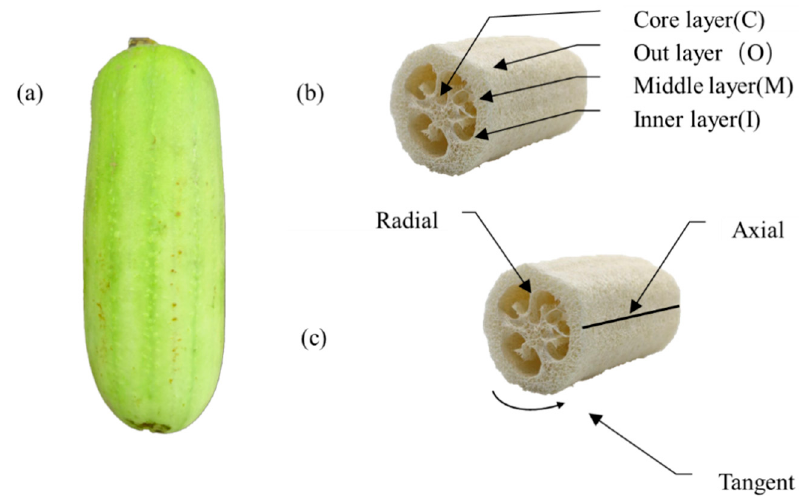
Figure 1. The structure of luffa sponge: ( a ) Nature luffa; ( b ) Four main parts of luffa sponge; O (out layer), M (middle layer), I (inner layer) and C (core layer); ( c ) Three main directions of luffa sponge.